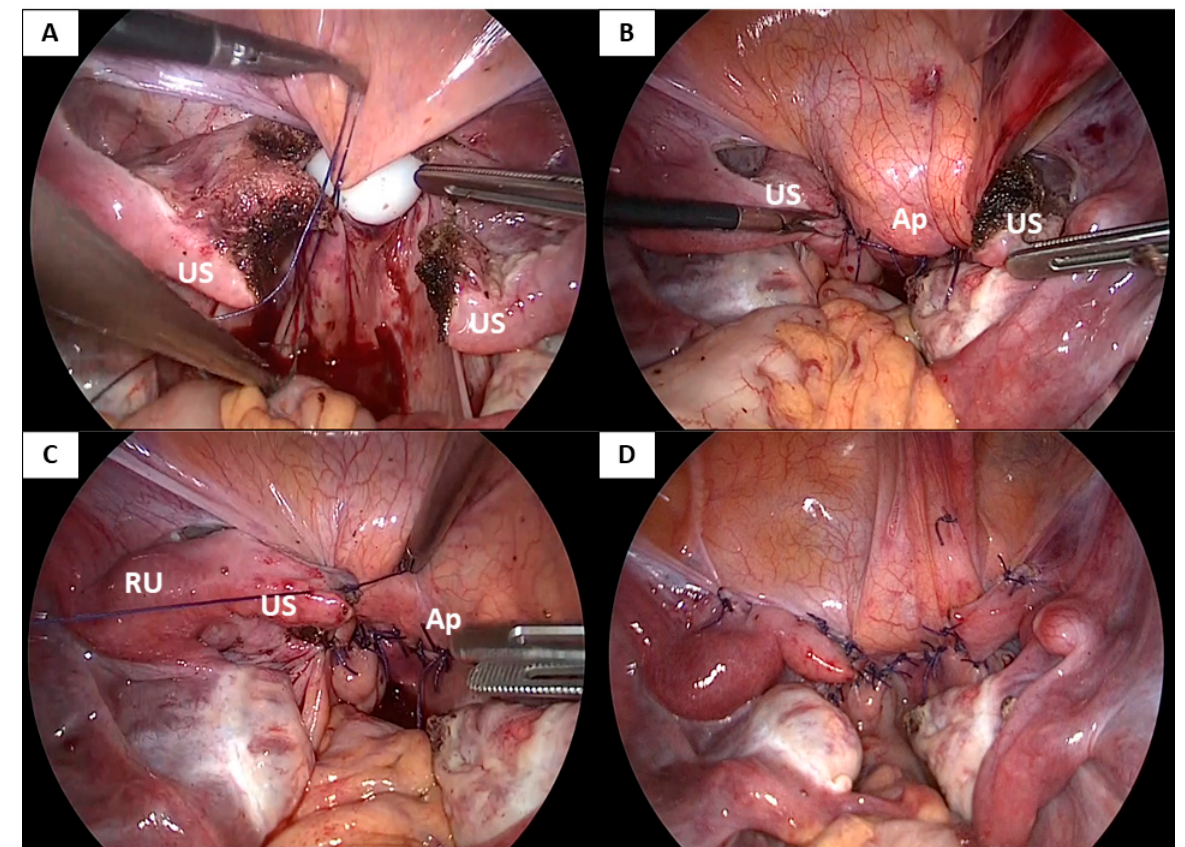
Figure 3. Creation of the neovaginal apex and additional structural support using the incised uterine strand. ( A ) The supravesical and suprarectal peritoneum are sutured at the target neovaginal length while inserting the mold. ( B ) The neovaginal apex is shown with the incised uterine strand before it is used to create additional structural support. ( C ) The incised uterine strand is sutured to the lateral side of the neovaginal apex to cover the side wall of the neovaginal apex and fix the neovaginal canal within the pelvis. ( D ) A final laparoscopic view of the neovaginal apex with the additional structural support created using the incised uterine strand in the Kisu modification technique. US; Uterine strand, RU; Rudimentary uterus, Ap: Apex of the neovagina.